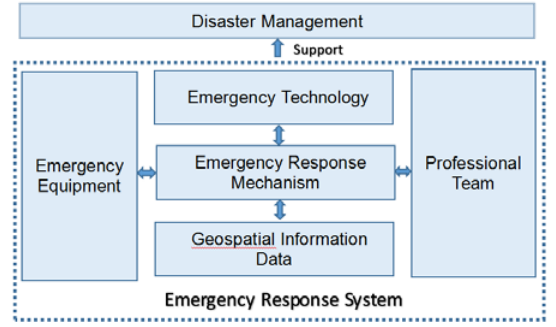
Figure 2. General Framework of the System